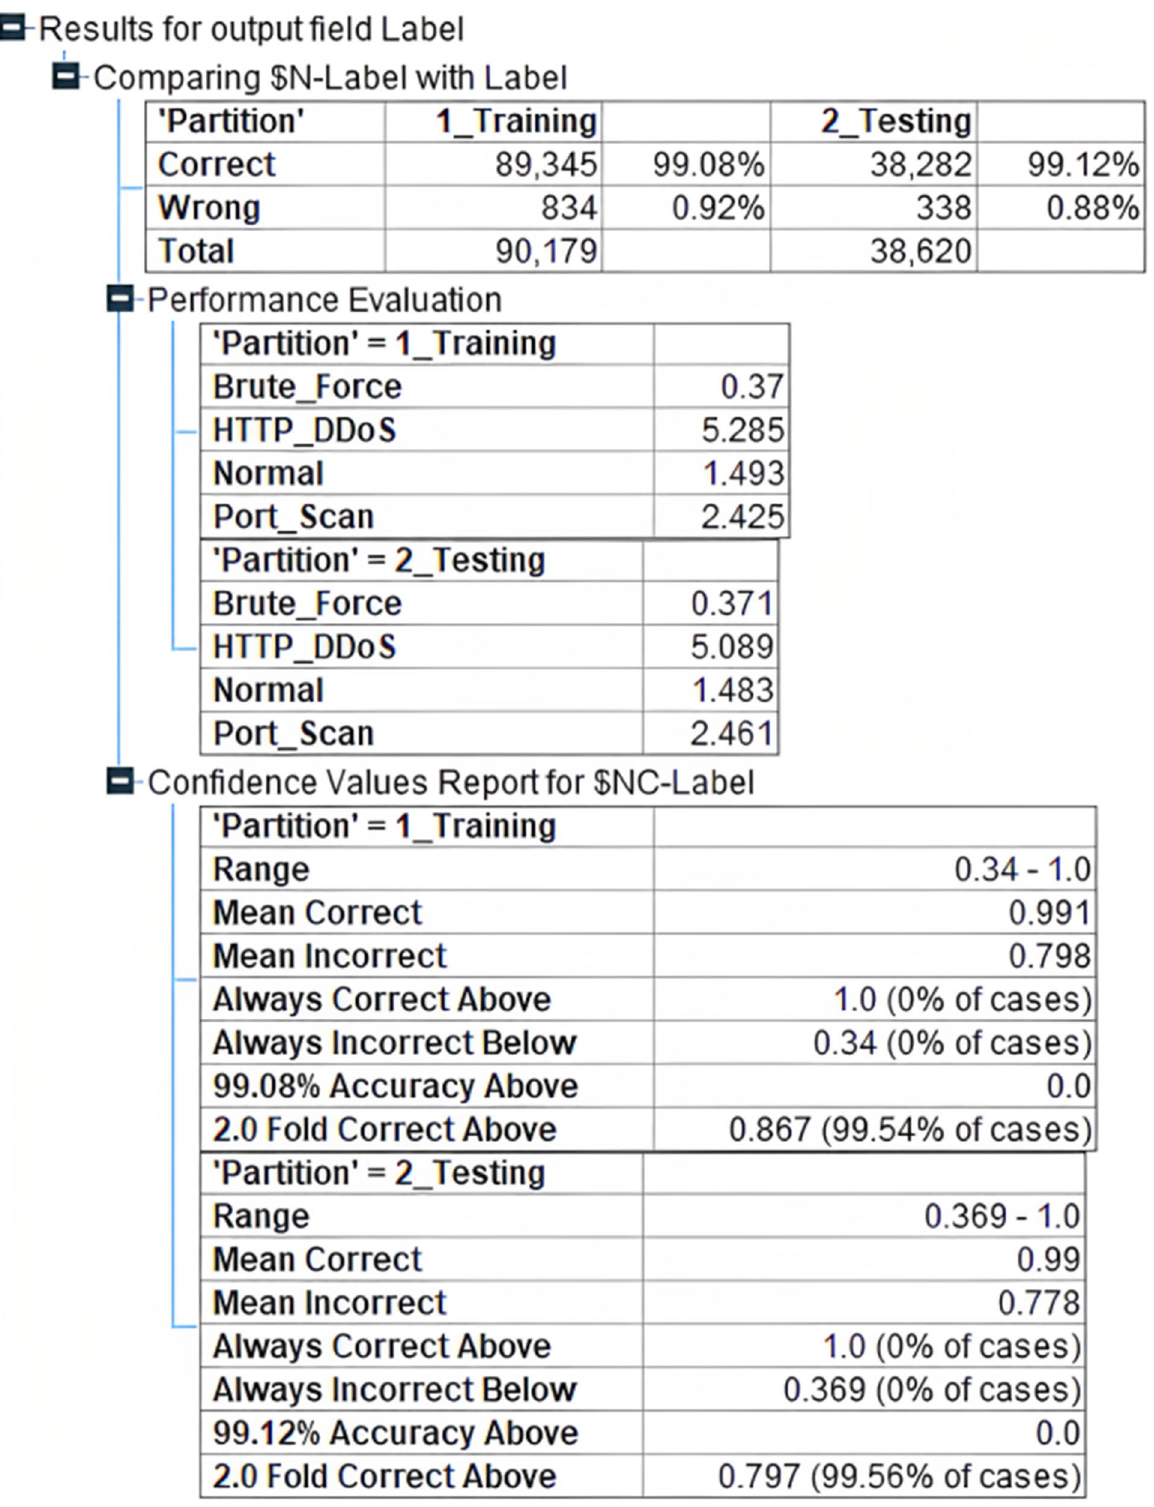
Fig. 9 Accuracy level in neural